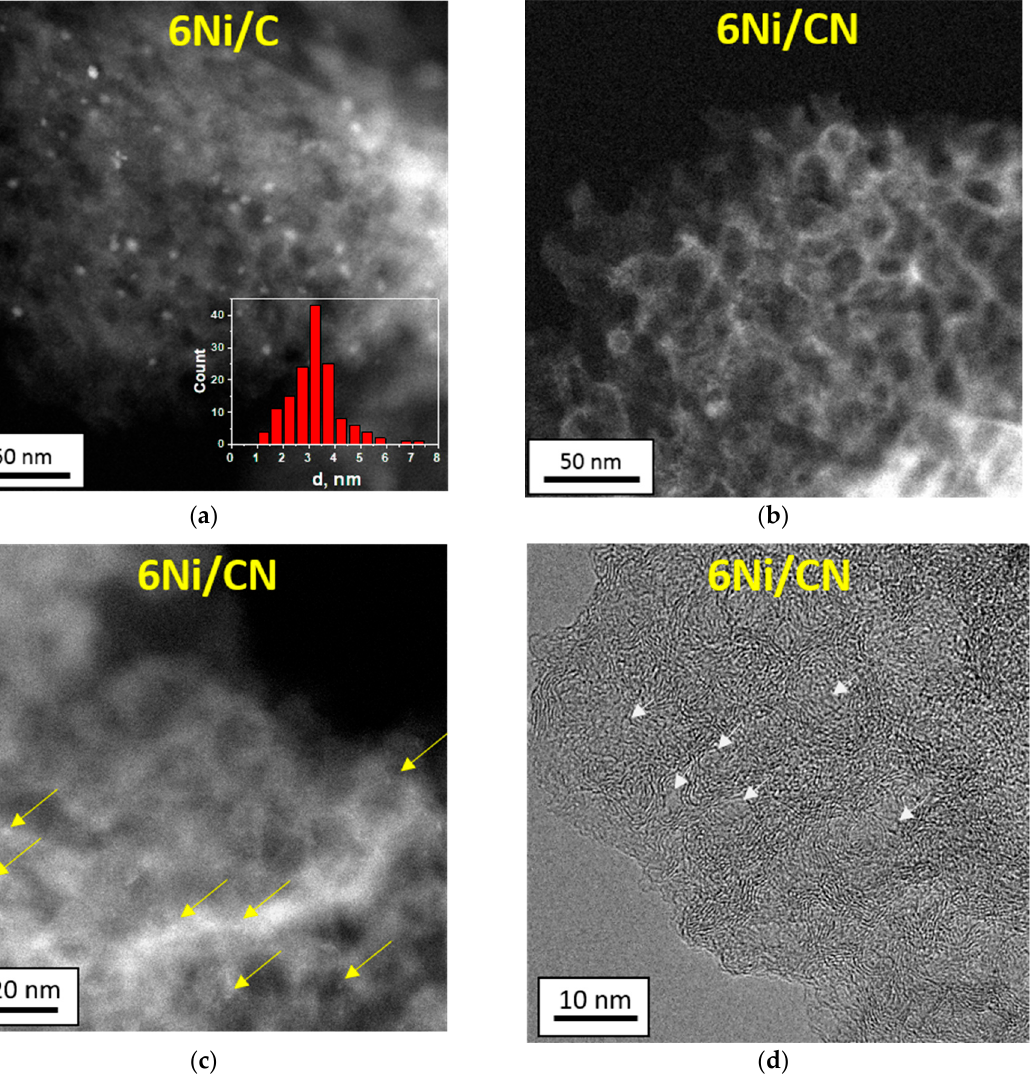
Figure 1. HAADF/STEM low-magnification images of ( a ) 6Ni/C and ( b ) 6Ni/CN and ( c ) high-magnification image of 6Ni/CN. Inset in ( a ) presents the size distribution of nanoparticles. Yellow arrows in ( c ) indicate Ni sub-nanospecies. ( d ) High-resolution TEM image of the 6Ni/CN nanomaterial. White arrows show pores in the CN nanomaterial.